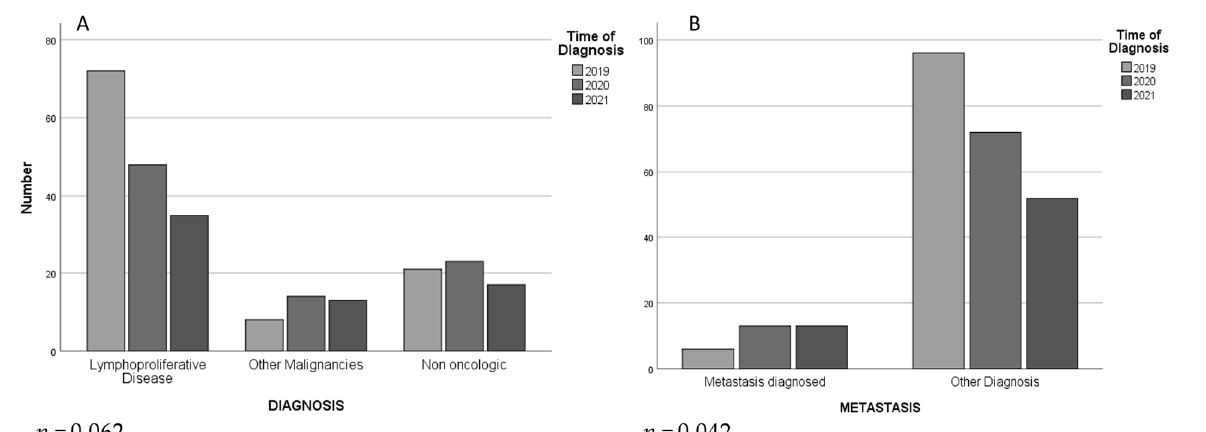
Figure 1. This figure shows number per year of diagnosis performed through lymph ‐ node biopsy. There is a decreasing trend of lymphoproliferative disease ( A ) and a significant increasing of distal metastases ( B ) diagnosed from 2019 to